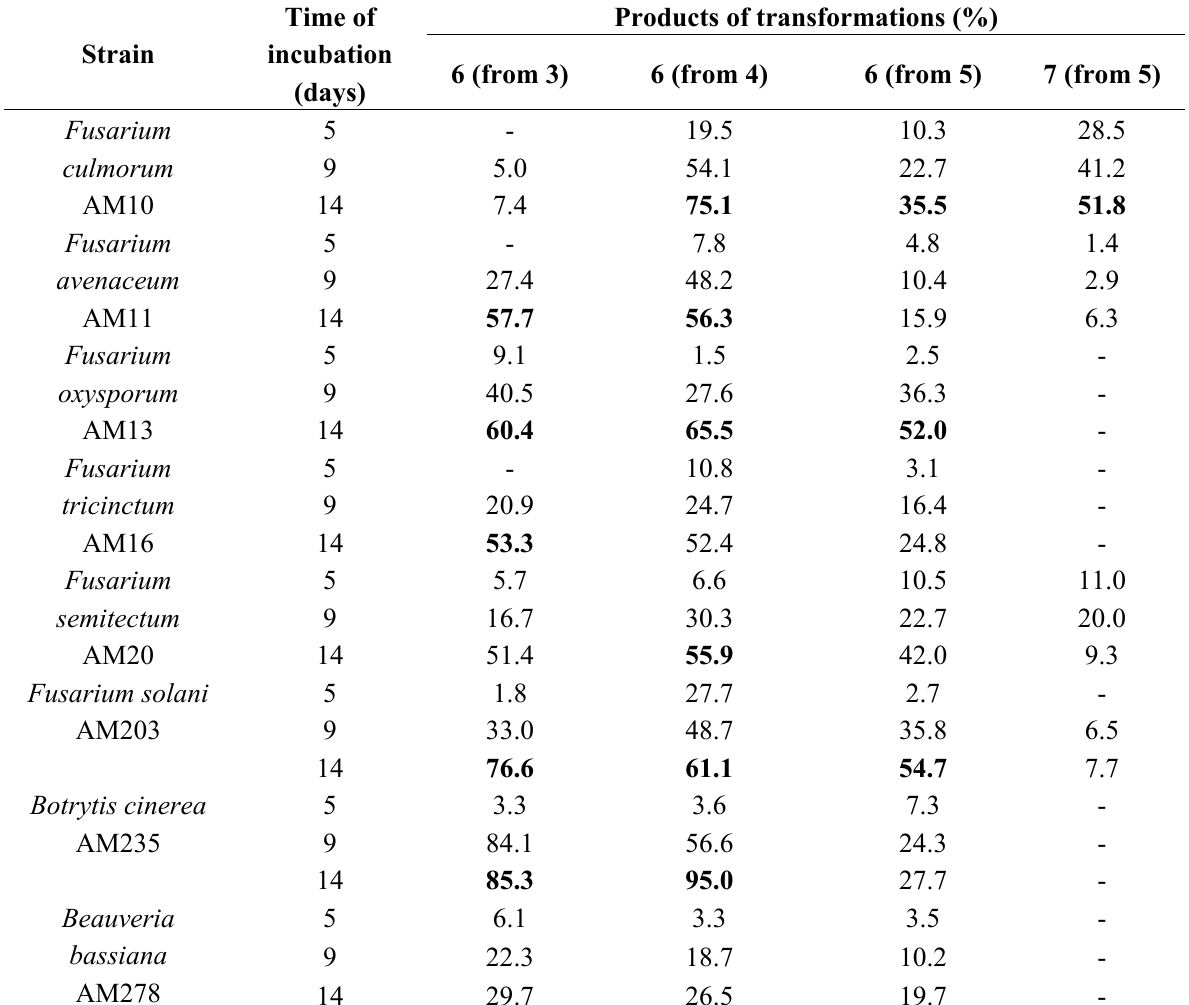
Table 1. The composition (in % according to GC) of the product mixtures of screening biotransformations of lactones 3 , 4 , 5